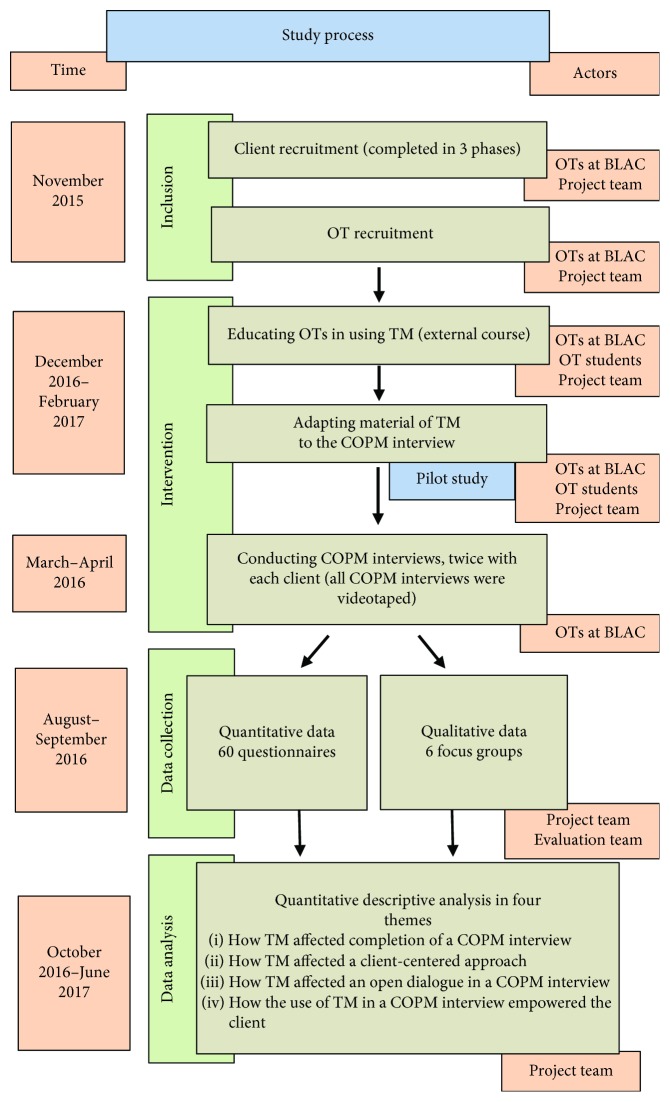
The study process.